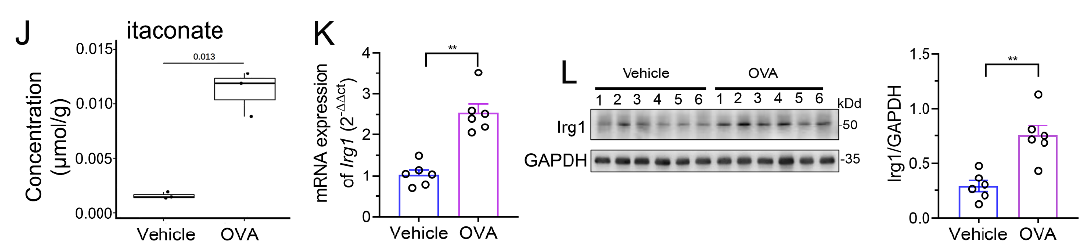
Figure 1. Itaconate level and Irg1 expression are induced in OVA − induced allergic airway inflamma- tion. ( A ) Representative images of BALF cells stained with Wright–Giemsa solution. Scale bar: 50 µ m. ( B ) The number of total inflammatory cells, eosinophils, macrophages, neutrophils and lymphocytes in BALF. ( C ) The optical density value (OD value) measured at 450 nm represents the level of IgE in serum. ( D ) The level of Th2 cytokines IL-5, IL-4 and IL-13 in BALF. ( E ) Representative blots showing the protein expressions of Th2 cytokines IL-5, IL-4 and IL-13 in lung tissues from vehicle and OVA groups. ( F ) Quantification of the expression of IL-5, IL-4 and IL-13 in the lung as referencing to GAPDH. ( G – J ) TCA organic acid metabolomics analysis in vehicle and OVA group. n = 3 per group. ( G ) Principal component analysis (PCA) in vehicle and OVA group. ( H ) Heatmap of metabolites obtained by TCA organic acid metabolomics analysis in vehicle and OVA group. ( I ) Fold change of metabolites in OVA group as compared with vehicle group. ( J ) The level of itaconate in lung tissue. ( K ) The mRNA expression of Irg1 in lung tissue. ( L ) Representative blots showing the protein expressions of Irg1 in lung tissues from vehicle and OVA groups and quantification. Cropped blots are shown, and Supplementary File S2: Figures S1 and S2 present the full-length blots. Data expressed as means ± SEM ( n = 6). ** p < 0.01.